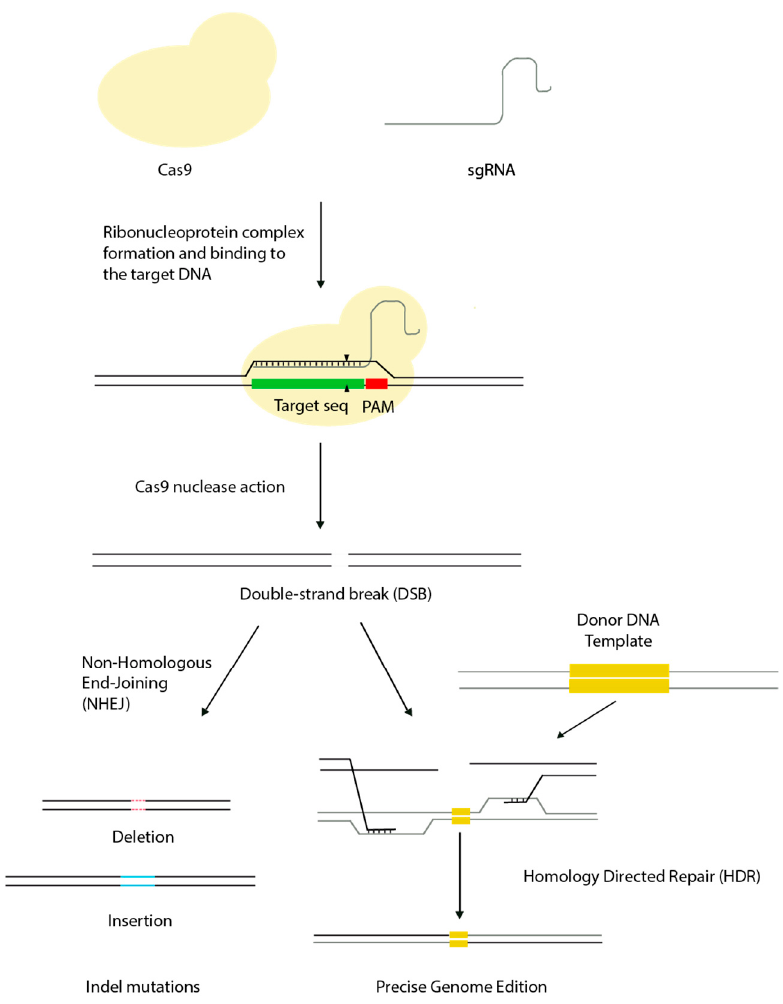
Figure 1. Clustered regularly interspaced short palindromic repeats (CRISPR)/Cas9 mechanism of action. Protein Cas9 binds to the sgRNA, forming a ribonucleoprotein complex (RNP). This complex then anneals to the genomic target sequence with base-pairing complementarity and specifically cleaves double-stranded DNA (black triangles) after the recognition of the protospacer-adjacent motif (PAM) sequence adjacent to the target sequence. Double-strand breaks generated activate non-homologous end joining (NHEJ) or homology-directed repair (HDR) pathways. In the absence of a homologous repair template NHEJ usually result in indels (insertions or deletions) of random base pairs disrupting the target sequence. Alternatively, precise genome edition can be made by providing a donor DNA template and exploiting the homology directed repair pathway.